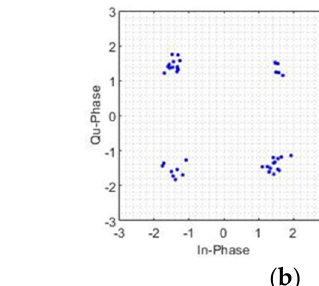
Figure 7. ( a ) Transmitted QPSK signal. ( b ) Recovered QPSK signal. Figure 8a,b show the constellation diagrams corresponding to the transmitted and received signal, respectively.